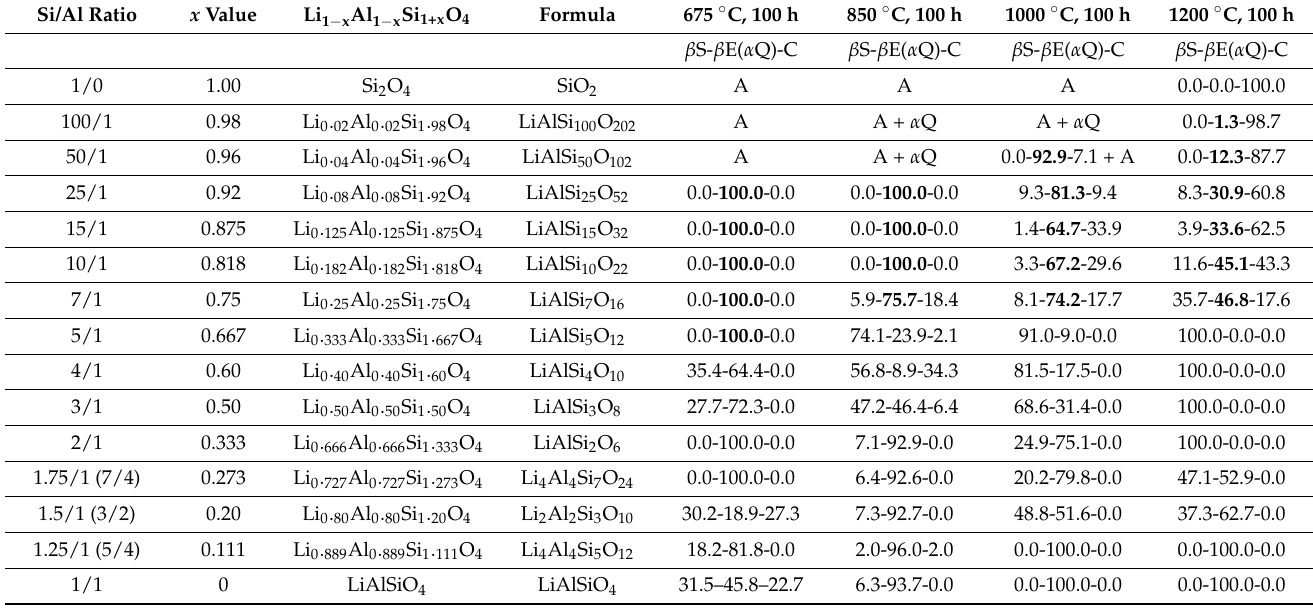
Figure 1. Simplified phase diagram of the Li 2 O–Al 2 O 3 –SiO 2 (LAS) system corresponding to the compositional range between LiAlSiO 4 and SiO 2 calculated in [52]. The experimental temperatures and chemical compositions for the synthesis of samples are shown in the y axis and x axis, respectively. The selected samples with single-phase compositions for the NMR spectra are shown. Table 2. Chemical compositions and crystalline phases produced by the thermal